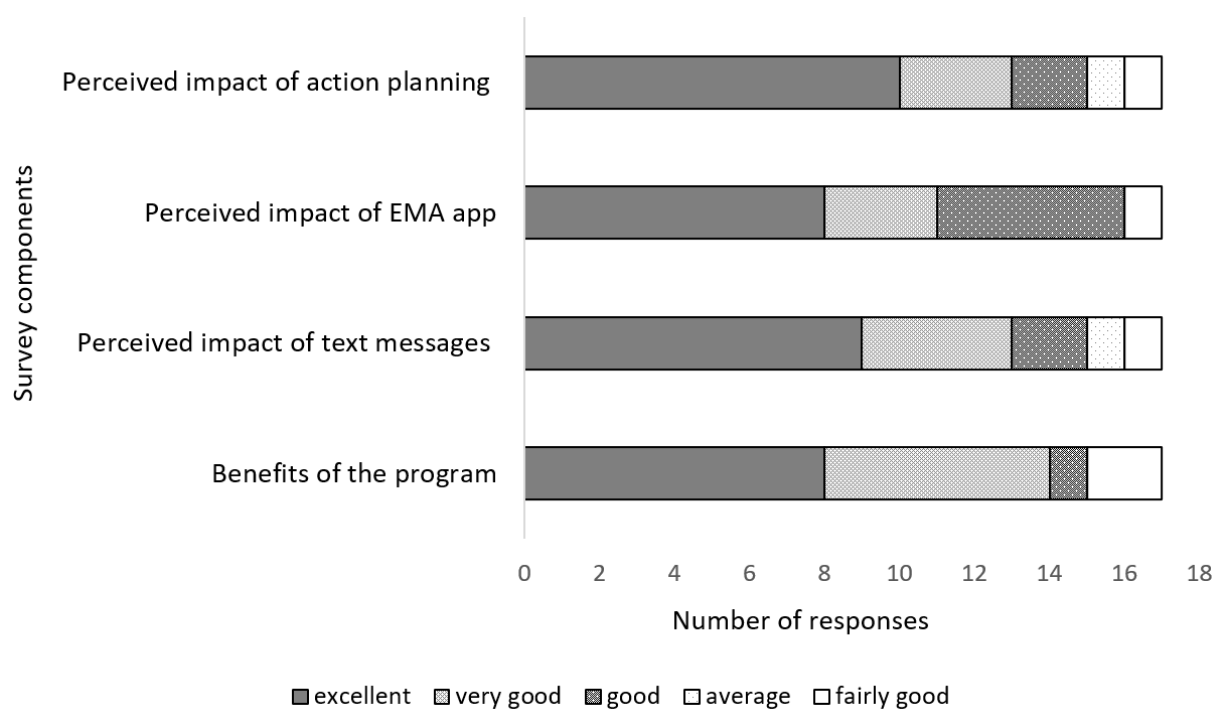
Figure 2. Summary of exit survey questions on adoption of intervention components. Perceived impact of action planning : participants reporting how they rate action planning, Perceived impact of EMA app : participants reporting their rating for the EMA app, Perceived impact of text messages: participants reporting their rating for the text messages, Benefits of the program : participants reporting their rating for the health promotion